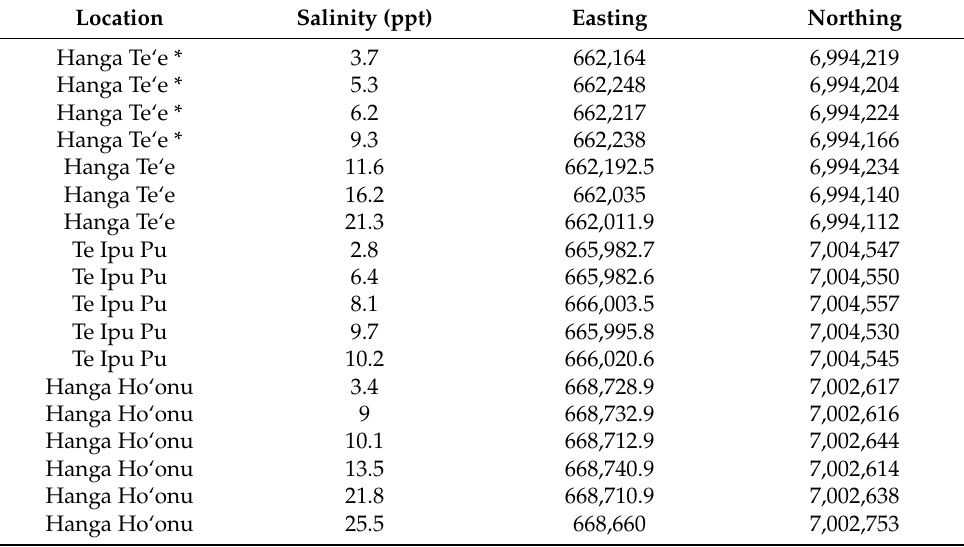
Table A1. Salinity values from study areas. Coordinates use WGS 1984 UTM Zone 12 S projection.